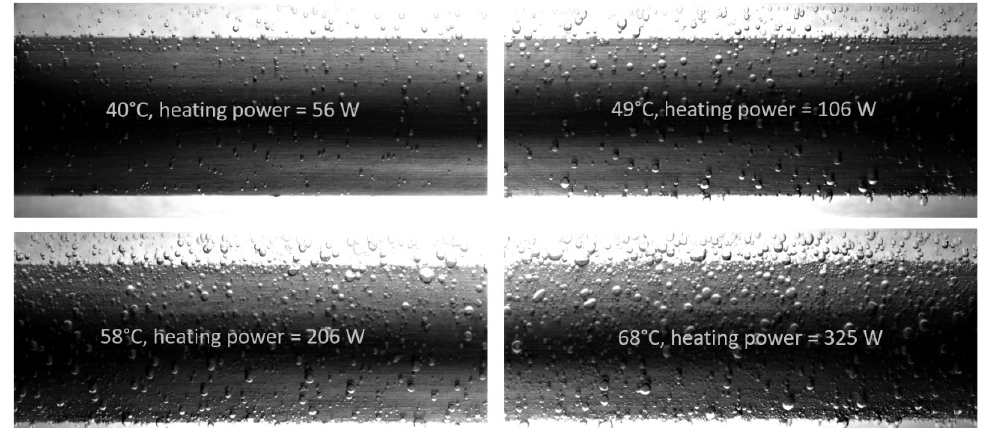
Figure 4. Image acquisition setup. ( a ) Camera and lighting configuration schematic (not to scale). ( b ) Image acquisition with Phantom v1212 camera in action.